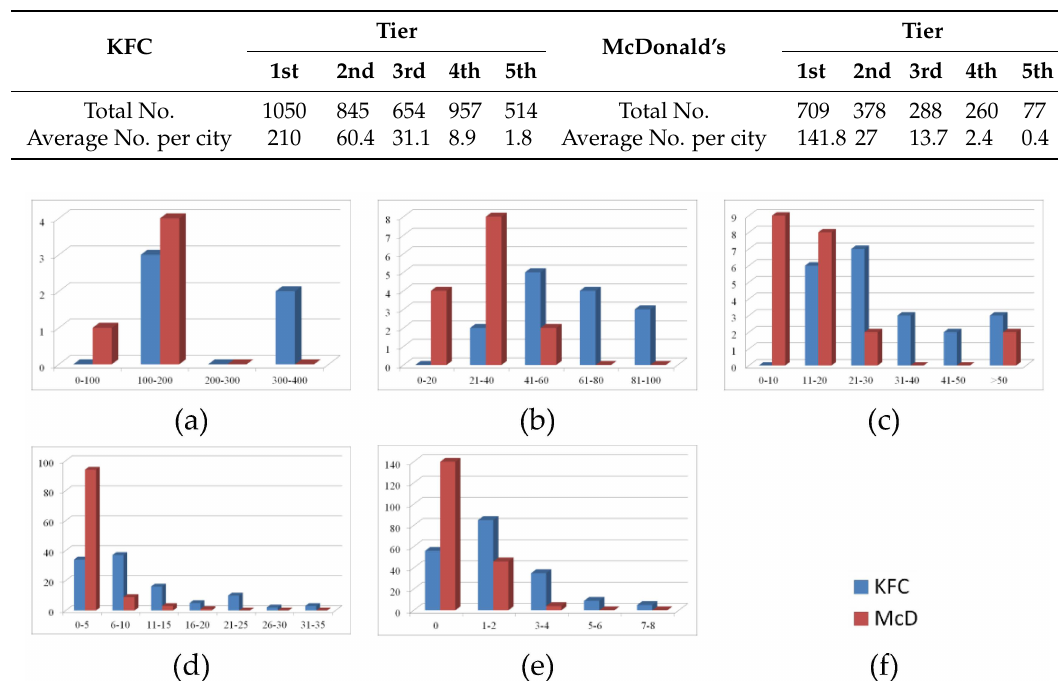
Table 2. The number of KFC and McDonald’s outlets in cities.